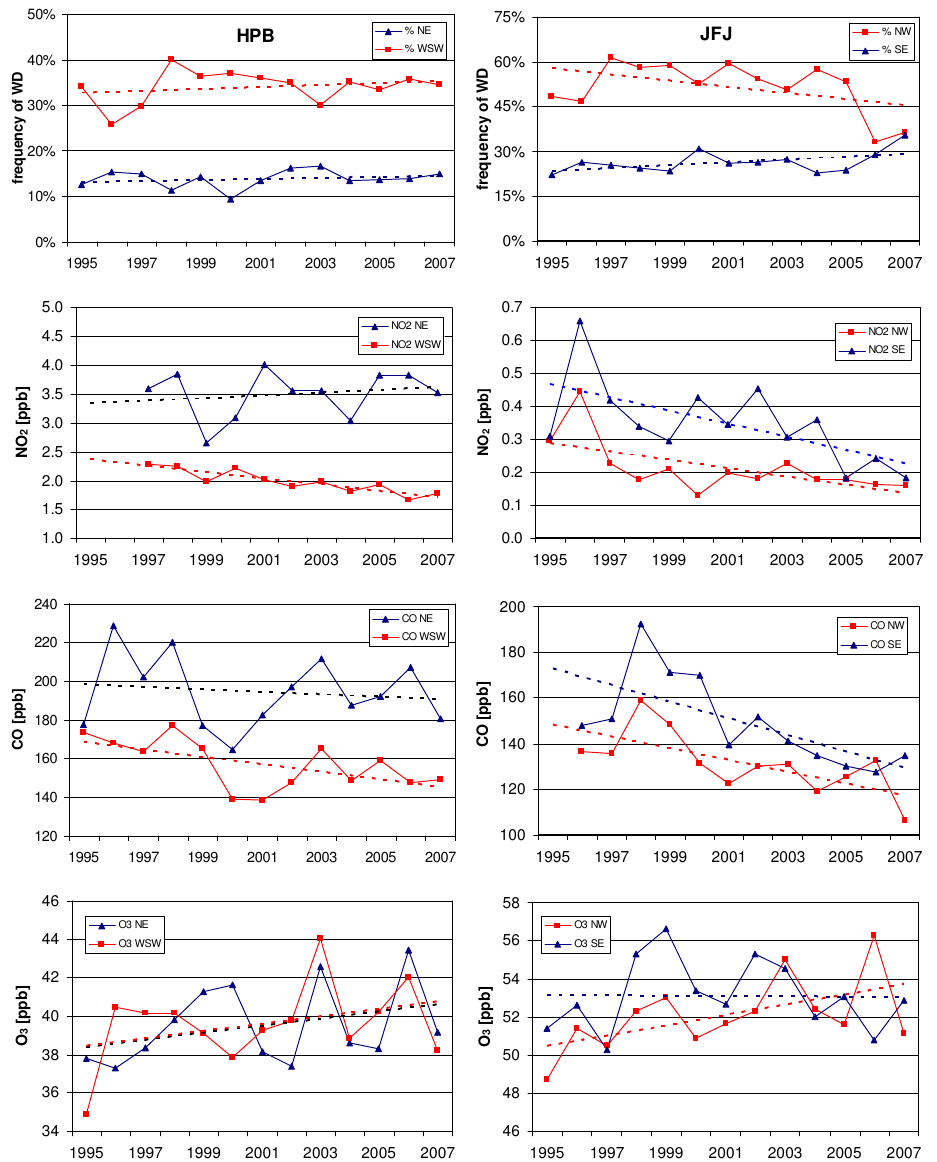
Fig. 17. Time series (1995–2007) at HPB (left column) and JFJ (right column) for the main wind sectors: (a) frequency of wind direction, Figure 17. Time series (1995-2007) at HPB (left column) and JFJ (right column) for the main 2 (b) O 3 , (c) CO and (d) NO 2 mixing wind sectors: a) frequency of wind direction, b) O 3 , c) CO and d) NO 2 mixing ratios. 3